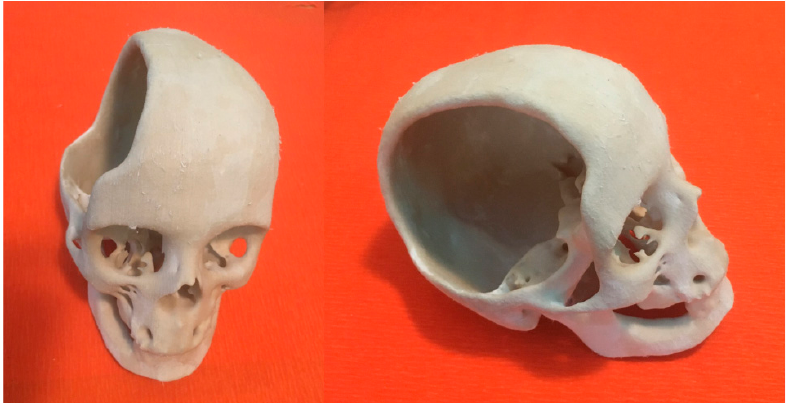
Figure 9. Images of the 3D physical model of a skull with a large cranial defect, which was previously fabricated by inkjet printing, starting from image capture and analysis techniques [1]: top-front view ( left ) and lateral view ( right ).